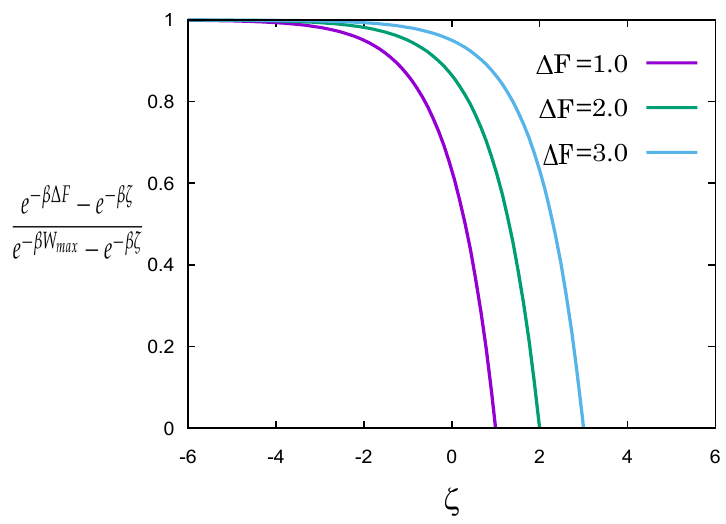
Figure 1. The lower bound lines for the probability P ( W ≥ ζ ) are provided by Equation (6) as a function of ζ for some fixed values of the free energy difference ∆ F . We used a fixed value of W max = 100 and β = 1.0. The bounds vanish when ζ = ∆ F . Also with other values of W max and β , the behaviour is